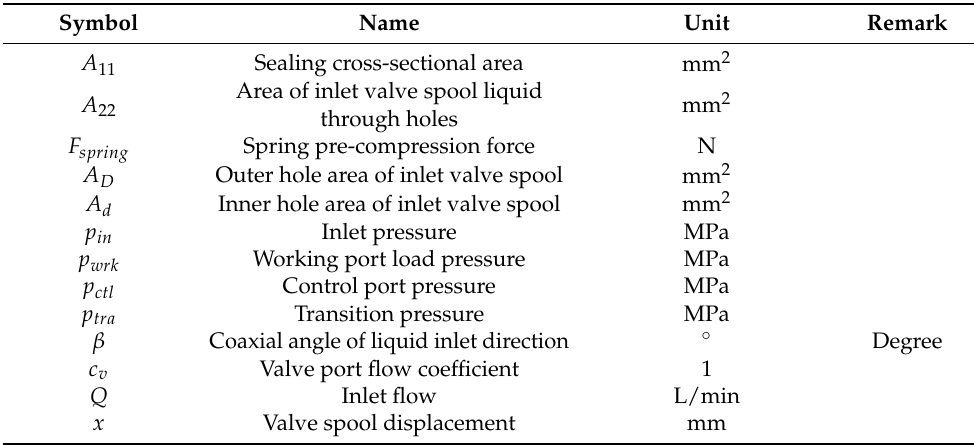
Table 1. Formula variable